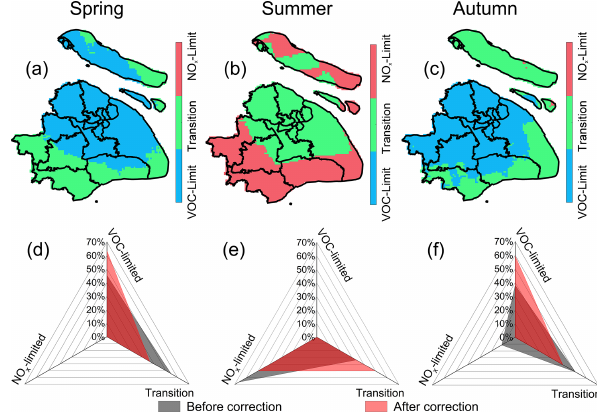
Figure 10. Spatial distribution of O 3 formation regime (a–c) and area proportion for each regime (d–f) after correction for different seasons in Shanghai during